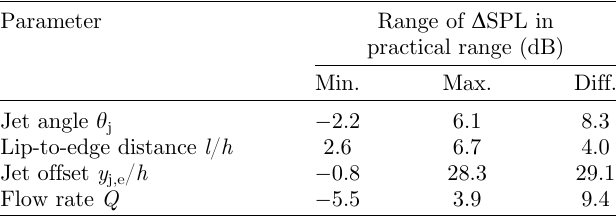
Table 4. Variation of D SPL with parameters in practical